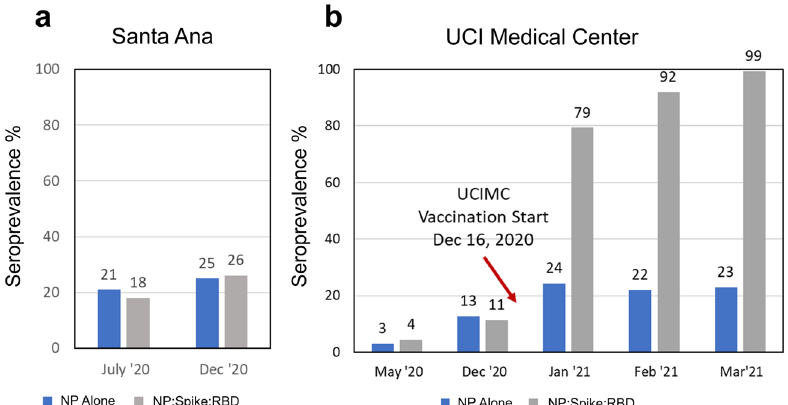
Fig. 2 Coronavirus seroprevalence of Naturally exposed and Vaccinated populations. a Finger stick blood specimens were collected from Orange County in July (2979 specimens) and Santa Ana in December (3347 specimens), and seroprevalence measured on the COVAM array. b Seroprevalence in cross-sections from the UCI Medical Center was measured by COVAM analysis in May and December before the start of the mRNA vaccination campaign on December 16, 2020 and monthly post vaccination time points in 2021. The gray bar is the COVAM seroprevalence prediction and the blue bar is the nucleocapsid protein seropositivity. The graph shows the increase in reactivity to Spike-RBD in relation to the nucleoprotein in the vaccination population reaching a seropositivity of 99% as opposed to 23% (for the NP). For the Santa Ana population, an increase in seroprevalence was observed, but no differential increase for Spike-RBD was